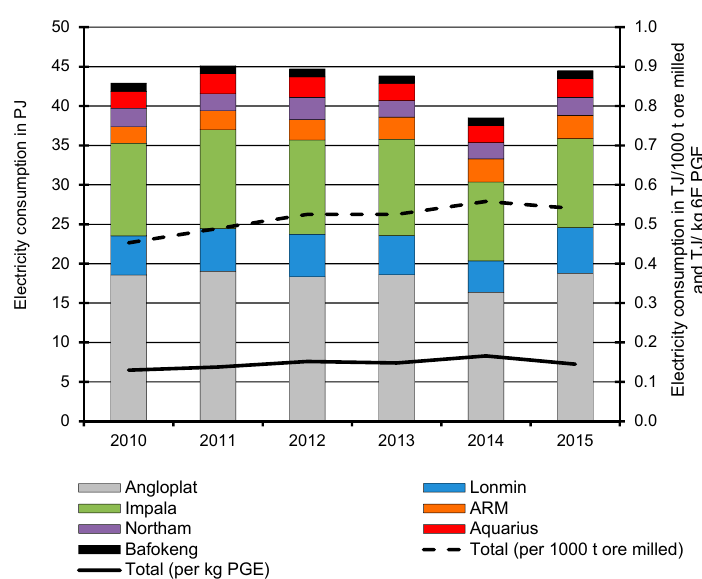
Figure 5. Electricity consumption per company: ( left axis ) per kg 6E PGE; and ( both right axis ) per 1000 t ore milled. Based on data from [15,54–84].